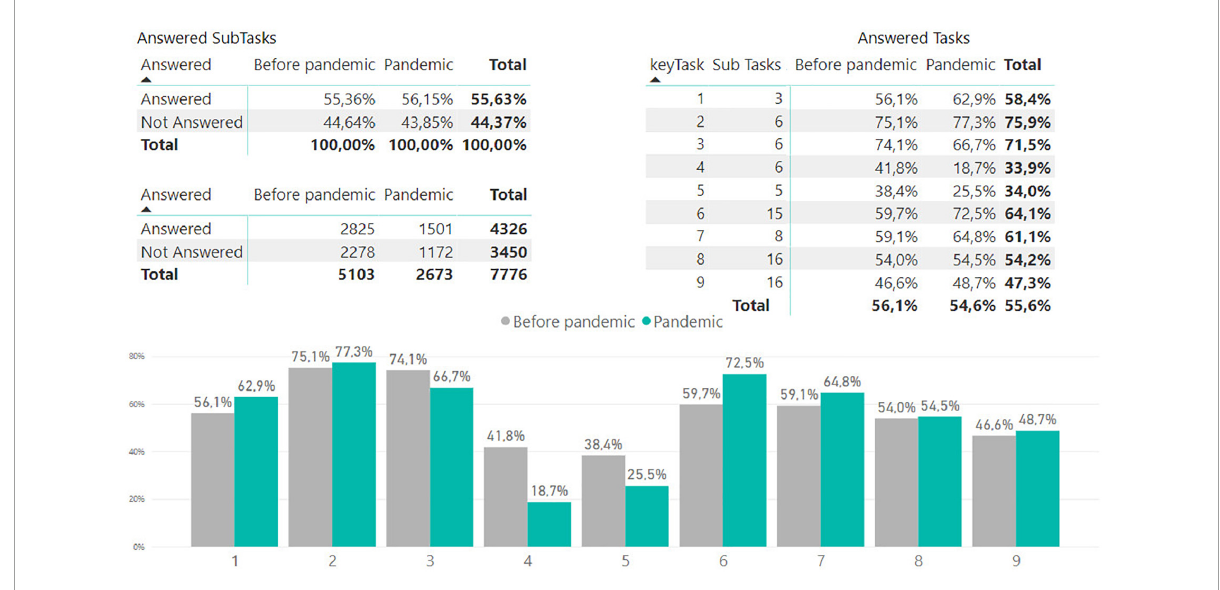
FIGURE2 Answered subtasks before and during the pandemic on